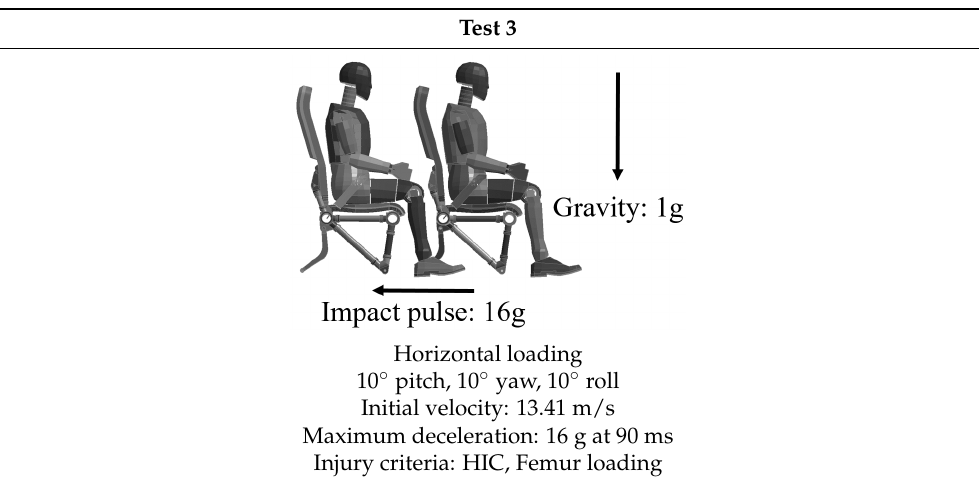
Table 2. Test 3 description.